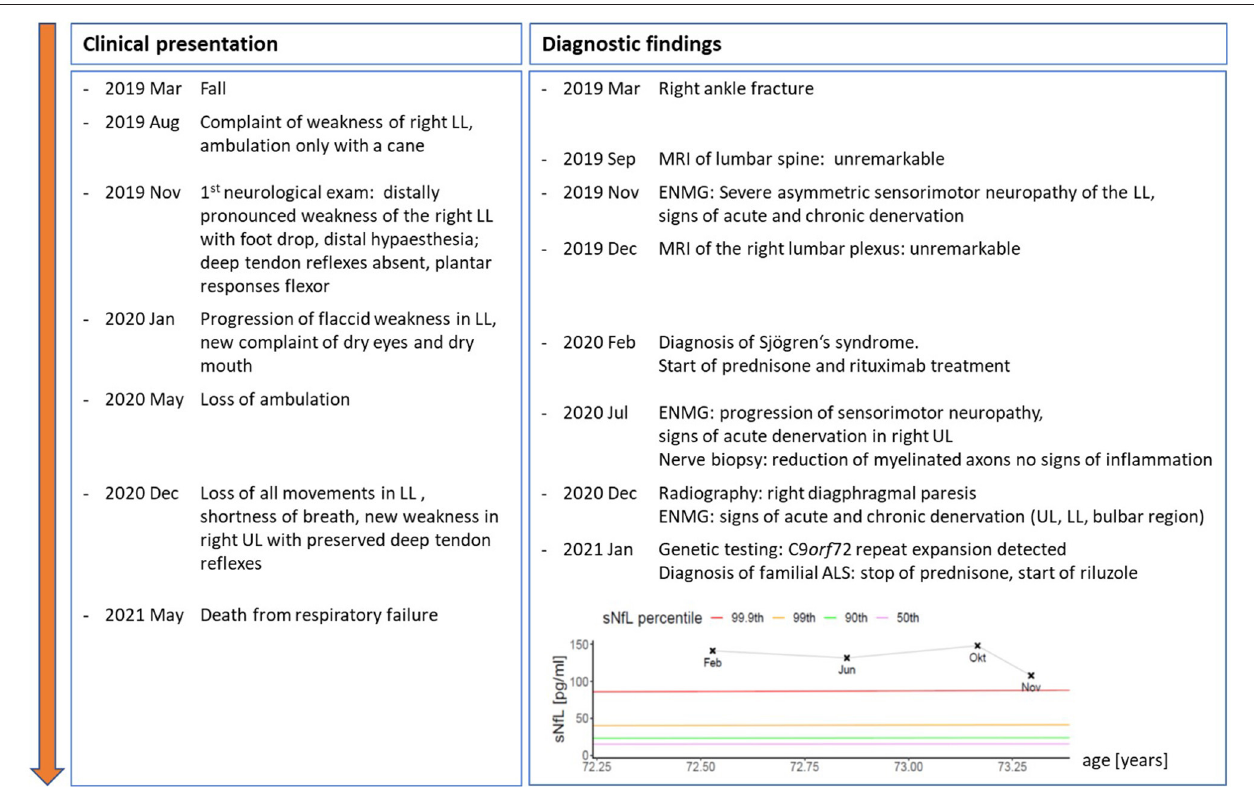
FIGURE 1 | Time course of clinical symptoms and signs as well as results from ancillary examinations and therapeutic interventions from symptom onset to death. Inserted graph shows serial serum neurofilament light chain levels (sNFL) from Feb to Nov 2020, coloured lines give age- and BMI-adjusted percentiles of reference population (18). UL, upper limbs; LL, lower limbs; ENMG, electroneuromyography.